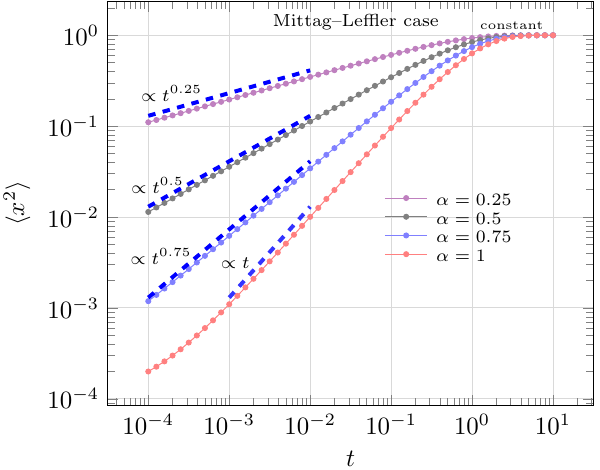
Figure 5. These curves illustrate the changes of MSD caused by a set of fractional α -index in Mittag-Leffler b − 1 = 0.5 and r = kernel, considering τ = 10 − 4 , D